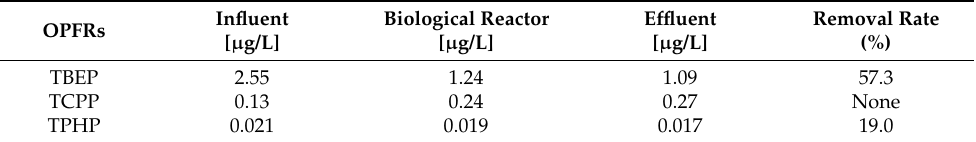
Table 1. The concentration of OPFRs in the influent, biological reactor, and effluent of the wastewater treatment plant. The following OPFRs were analyzed: TBEP ( tris (2-butoxyethyl) phosphate), TCPP ( tris (1-chloro-2-propyl) phosphate), and TPHP (triphenyl phosphate). When the removal rate of chemical was less than 0, it was expressed as none. Influent OPFRs [ µ